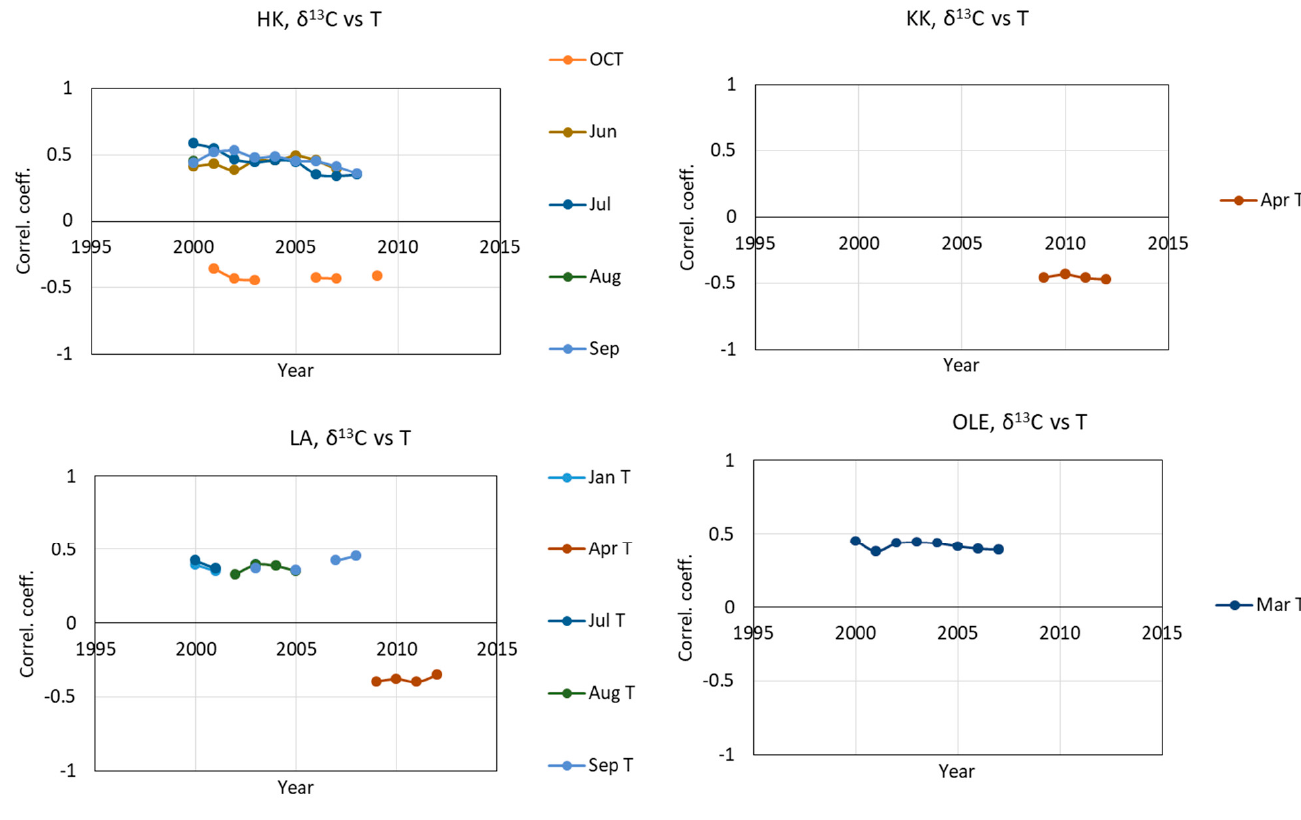
Figure 4. Changes in carbon stable isotope composition of tree rings ( a ) and iWUE ( b ) in pine grown in four forests in Silesia (Poland): HK − Dabrowa Górnicza, LA − Ł aziska Górne, KK − K ę dzierzyn Ko ź le, OLE − Olesno.